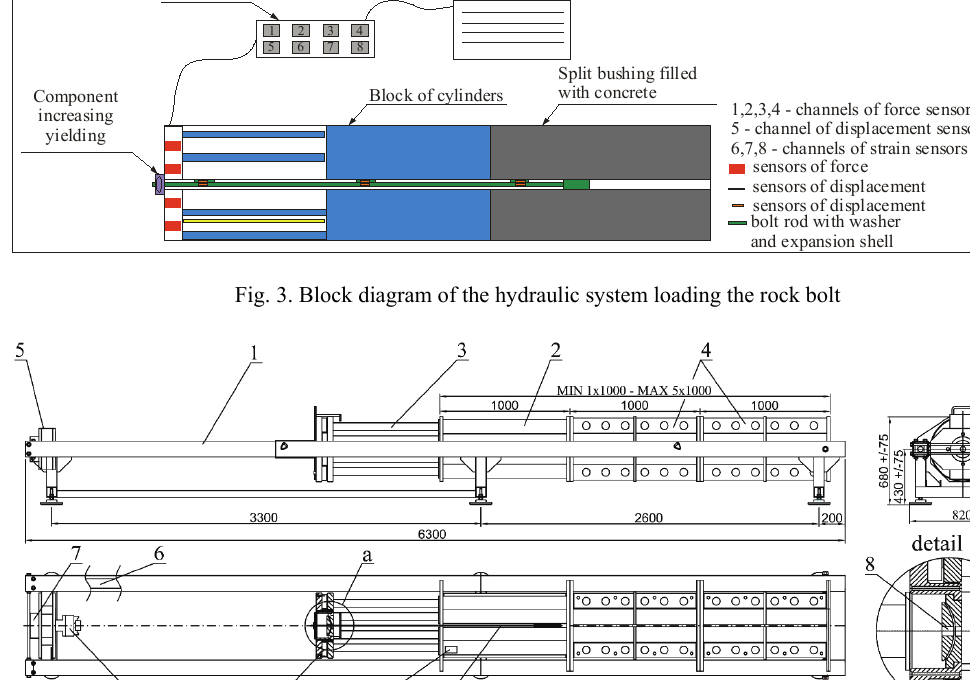
Fig. 3. The test rig allows 1:1 scale rock bolt testing,